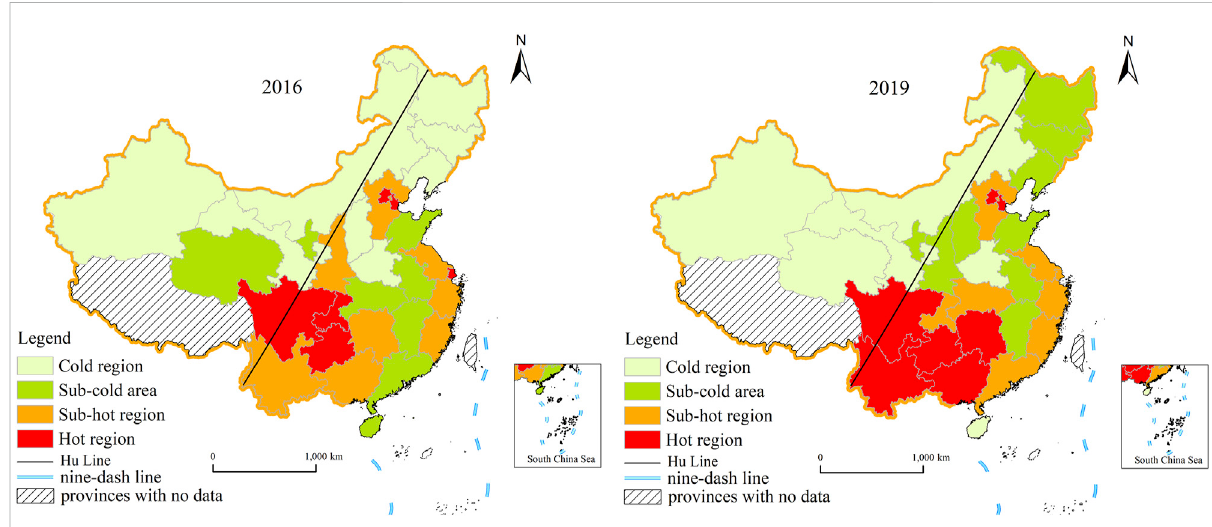
FIGURE 3 Hotspot distribution of the spatial distribution of TET in China. Note: The map is based on the standard map with review number GS (2019) 1697 downloaded from the Ministry of Natural Resources standard map service website, and the base map is unmodi fi ed (http://bzdt.ch.mnr.gov. cn/).